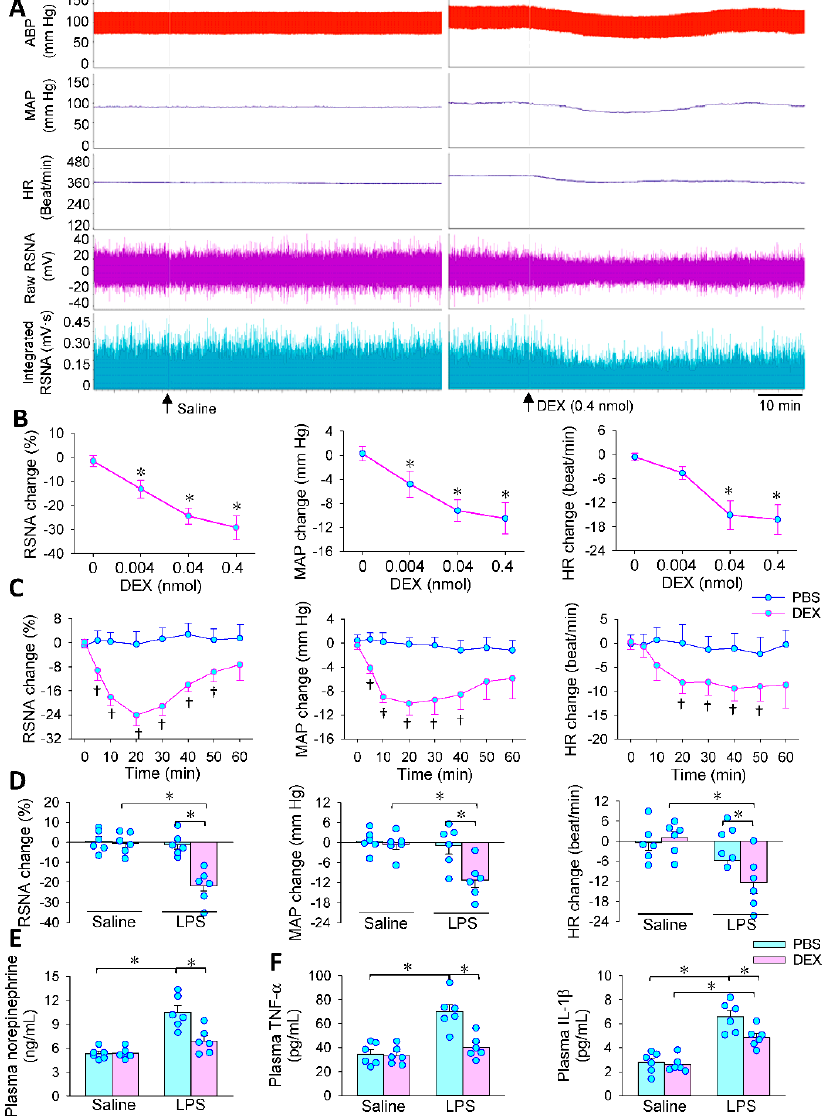
Figure 2. Roles of the DEX microinjection to the paraventricular nucleus (PVN) on LPS-induced RSNA, MAP and HR changes. The PVN microinjection was carried out 24 h after the intraperitoneal